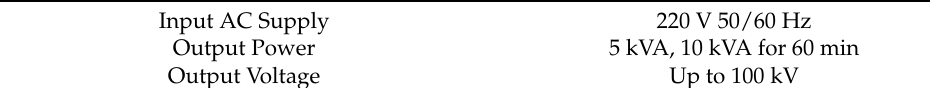
Table 3. Test transformer specifications.